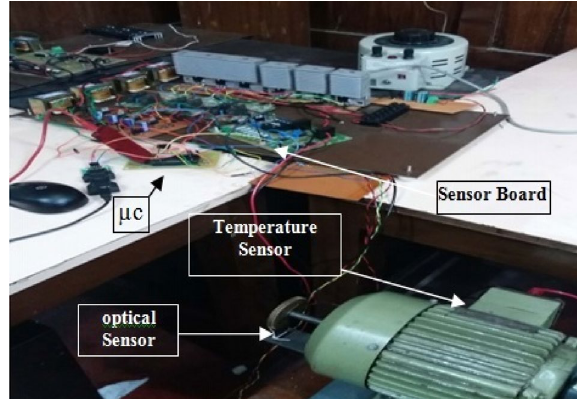
Fig. 17 Hardware prototype model of VSI-IM